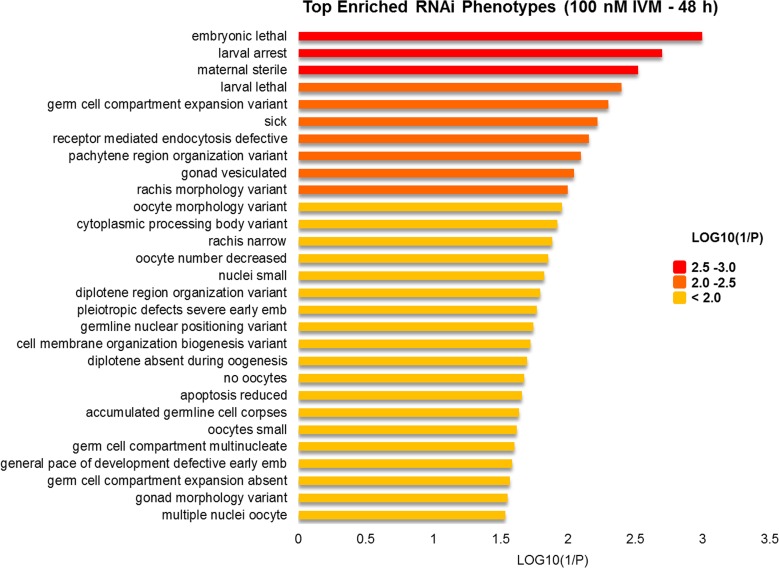
Top RNAi phenotypes enriched in reproductive processes after 48 h exposure to 100 nM IVM.The listed enriched phenotypes obtained were based on Gene Ontology analysis of C. elegans orthologs of DE genes. These phenotypes were significantly overrepresented compared with their overall abundance in the C. elegans RNAi phenotype dataset in Wormbase. Statistical method: Hypergeometric; p-value adjusted using the Benjamini-Hochberg multiple test adjustment (FDR<0.05).